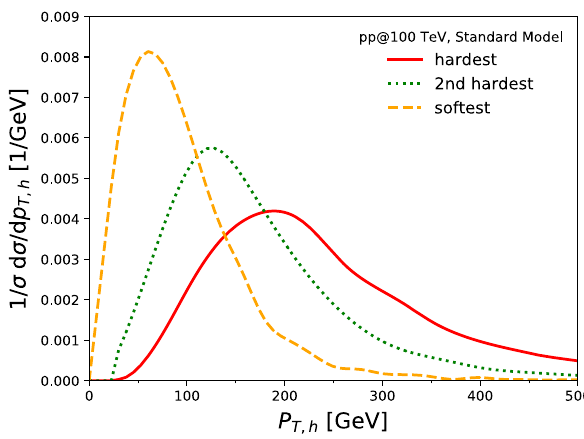
Fig. 2 The transverse momentum of Higgs bosons ordered from hard- est to softest (solid red, dotted green, dashed yellow, respectively), in triple Higgs production at the FCC-hh at 100 TeV, reconstructed from Monte Carlo truth with no cuts applied